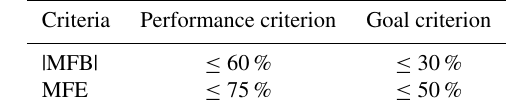
Table A2. Boylan and Russell